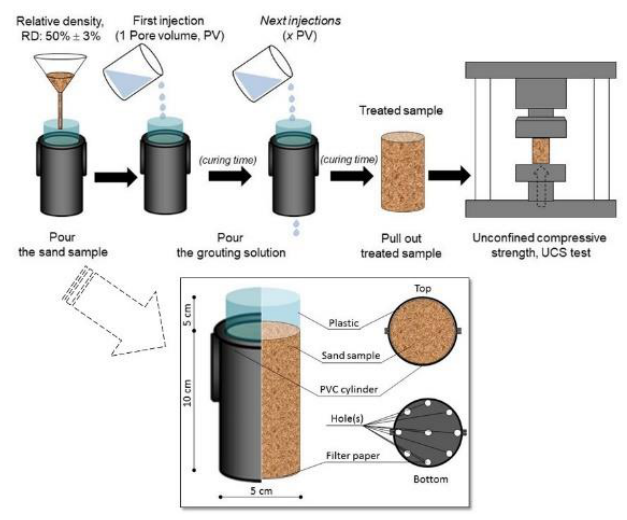
Figure 4. Procedure for sample preparation of UCS tests [19,20].